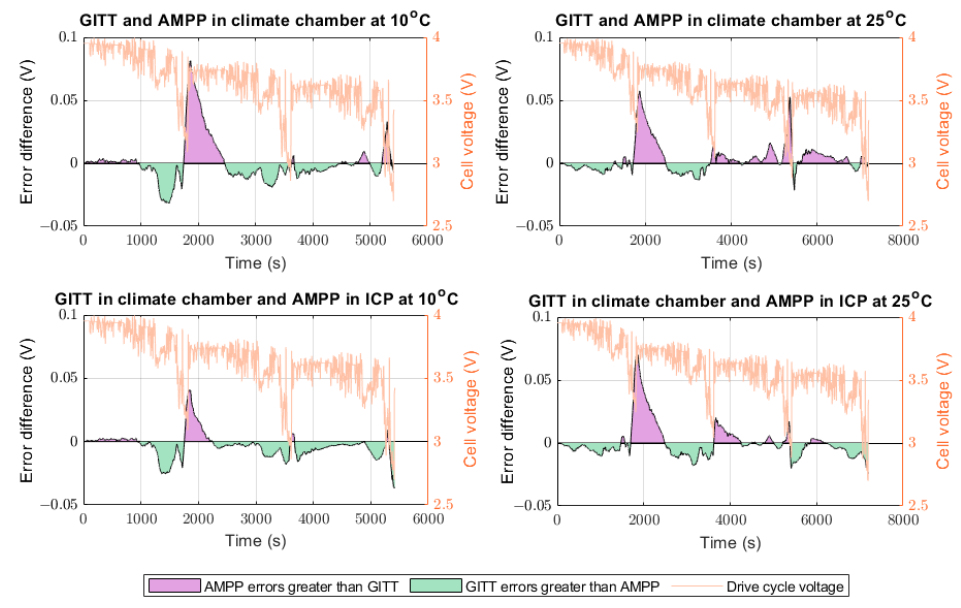
Figure 9. Difference in error between the ECM models parametrised using the different techniques against the WLTP drive cycle. The purple colour represents the region where the ECM produced from the AMPP data showed greater error than the ECM produced from the GITT data. The green colour represents the region where the ECM produced from the GITT data showed greater error than the ECM produced from the AMPP data.